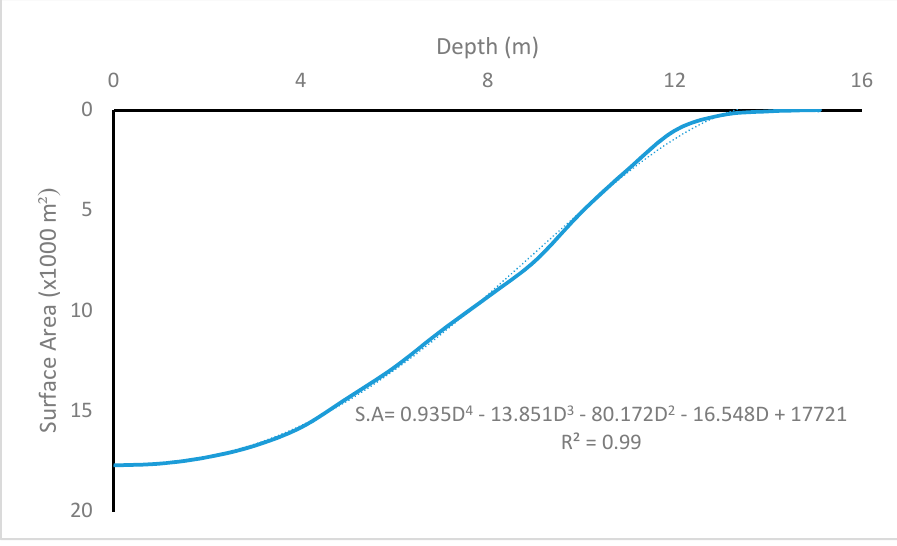
Figure 5. Depth–surface area relationship for Rungiri quarry reservoir.